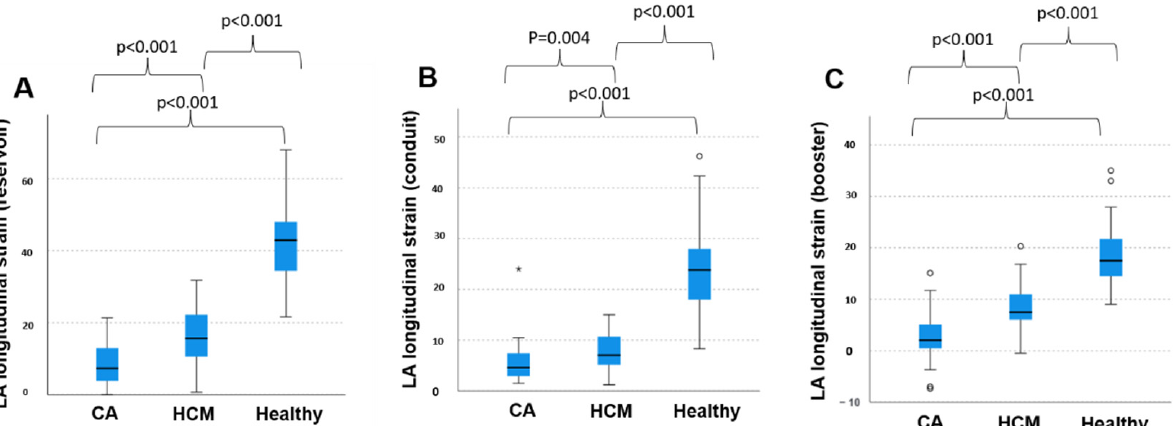
Figure 2. Left atrial strain in patients with cardiac amyloidosis and hypertrophic cardiomyopathy and healthy subjects. ( A ) Longitudinal left atrial reservoir strain, ( B ) longitudinal left atrial conduit strain and ( C ) longitudinal left atrial booster strain within the three groups, respectively. CA: cardiac amyloidosis; HCM: hypertrophic cardiomyopathy; LA: left atrial. *: extreme values, ○: outliers.